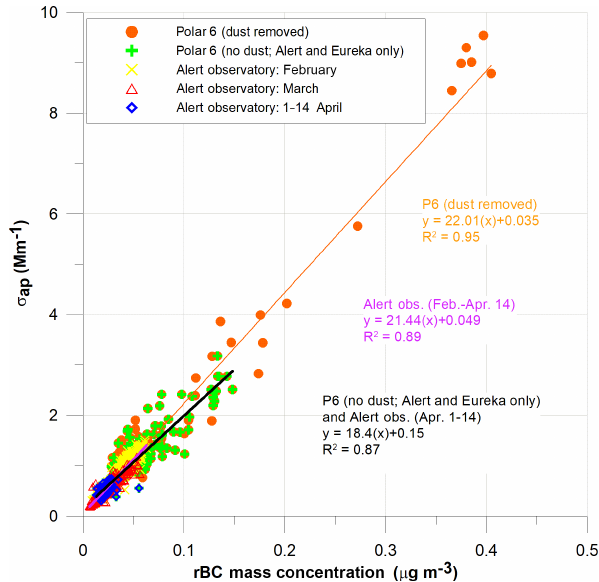
Figure 5. Particle light absorption coefficient ( σ ap ) at 550nm plot- ted against refractory black carbon (rBC) mass concentrations for all above-detection-limit data collected during Polar 6 flights from Alert, Eureka and Inuvik, NWT, with major dust influence removed (orange dots), for data collected during Polar 6 flights from Alert and Eureka only (green crosses) and for data collected at the Alert observatory. The Alert observatory data are separated between those collected during February, March and 1–14 April, where the latter corresponds most closely with the Polar 6 flights out of Alert and Eureka. Regressions are shown for all Polar 6 data (major dust re- moved; orange curve), for all Alert observatory data (purple curve) and for the Polar 6 data from Alert and Eureka combined with the Alert observatory data for 1–14 April (black curve).